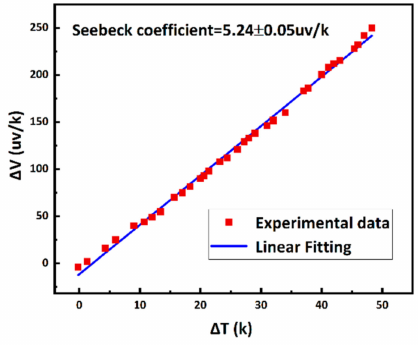
Figure 6. Calibration results for the Pd–Cr TFTC on a 3D